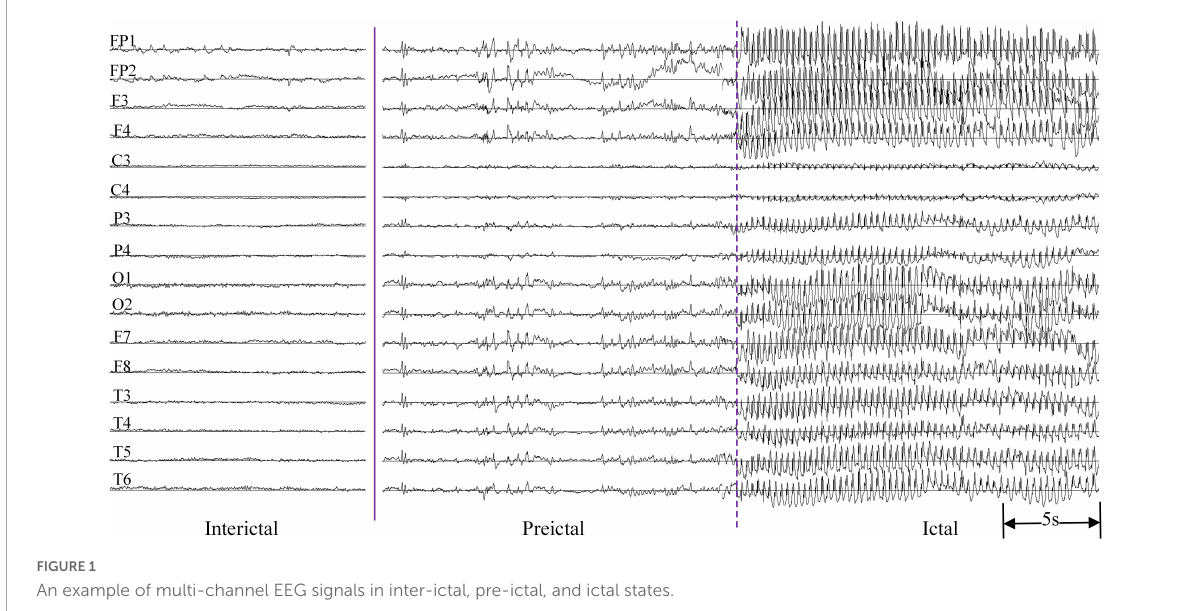
of the brain (subfigure 6), then covered the most range of the brain (subfigures 7–10), finally gradually decreased until the seizures stopped (subfigures 11–13). Note that the topographic map can not represent the power over time. The average PSD